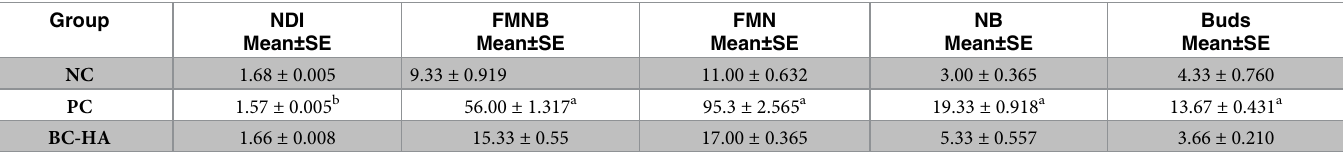
Table 4. Cytokinesis-blocked micronucleus assay results showing Mean and Standard Error values for Nuclear Division Index (NDI), Frequency of Micronucleus Binucleated Cells (FMNB), Frequency of Micronuclei (FMN), Nucleoplasmic Bridges (NB) and Nuclear Buds from each treatment with materials and controls.